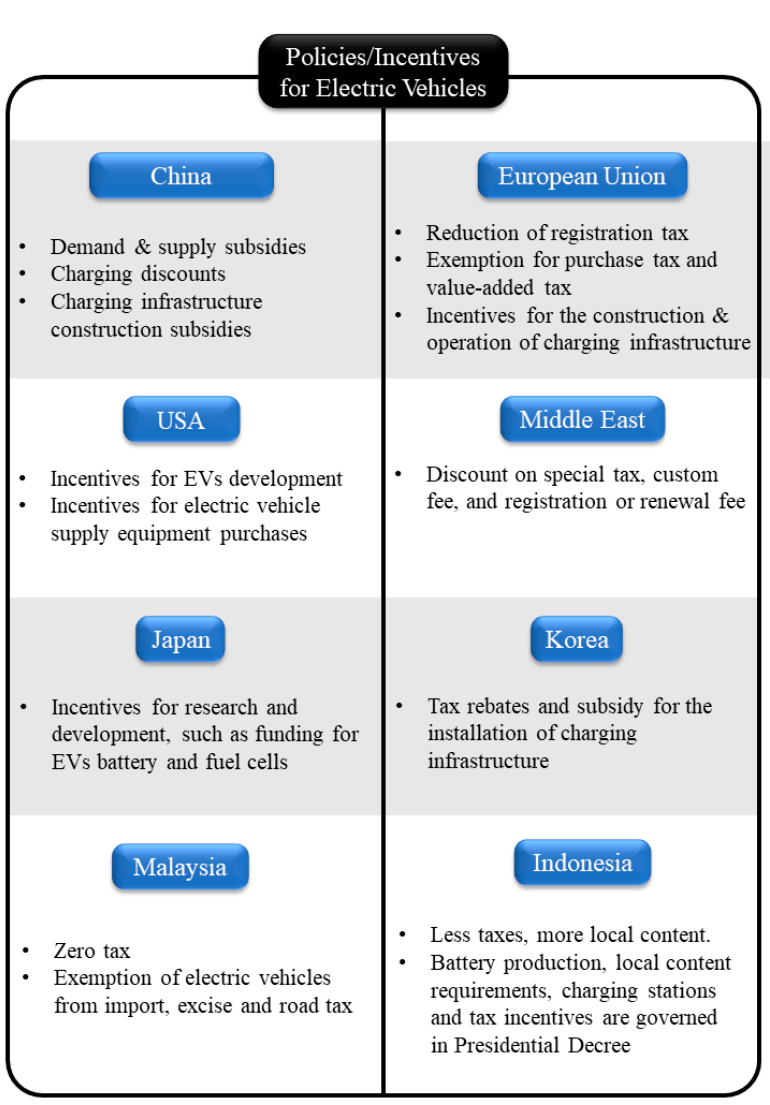
Figure 12. Policies and incentives for EVs in several parts of the world.